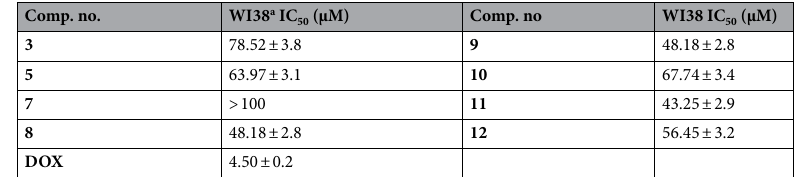
Table 2. In vitro cytotoxicity (IC 50, µM) of the tested compound and DOX against human normal cell line WI38. a Human lung fibroblast (WI38). IC 50 : compound concentration required to inhibit normal cell proliferation by 50% (mean ± SD, n = 3). IC 50 (µM). ϯ 1–10 (very strong), *11–25 (strong), 26–50 (moderate), 51–100 (weak), > 100 (non-toxic). DOX doxorubicin as a reference drug.